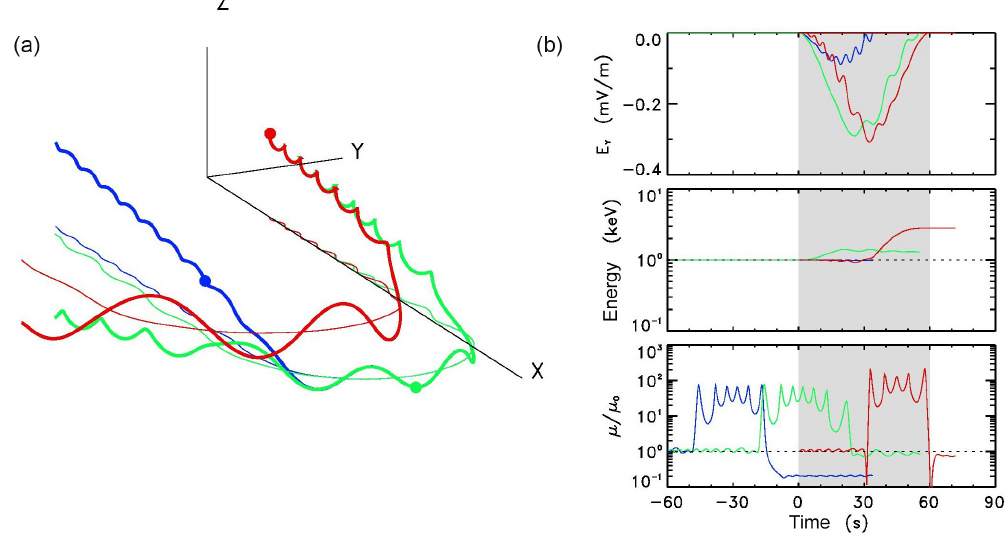
Figure 2. Left: three-dimensional trajectories of test H + launched at different (color-coded) times from Z = L . Thin lines show the H + trajectory projection in the equatorial plane. Right: color-coded electric field, energy, and magnetic moment versus time.